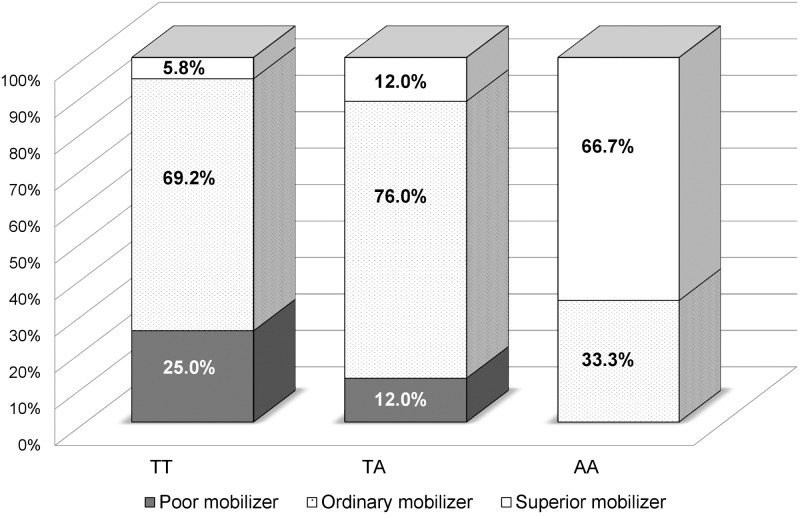
The rs11264422 genotype distribution of participants in the Korean set, classified by circulating CD34+ cell count.Superior mobilizers (> 200 cells/μL) had 66.7%, 12.0%, and 5.8% frequency rates in AA, TA, and TT genotypes, respectively. Poor mobilizers (< 20 cells/μL) had 25.0% and 12.0% frequency rates in TT and TA genotypes, respectively.